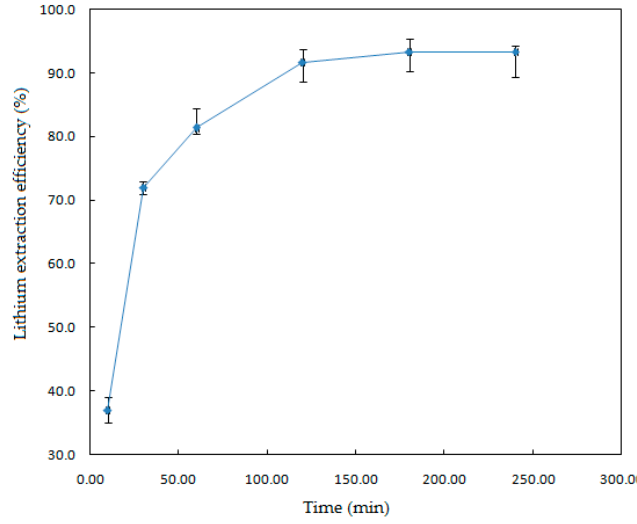
Figure 4. Effect of reaction time on the Li extraction efficiency.